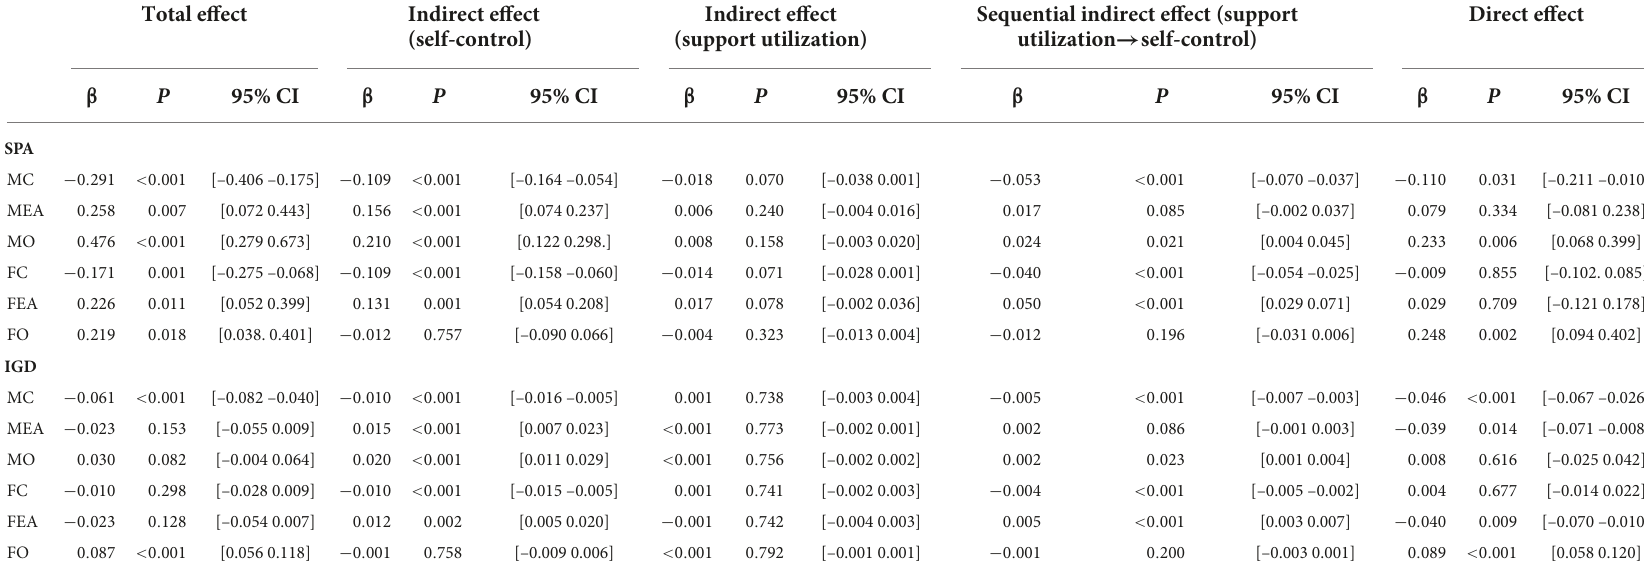
TABLE 7 Effects of support utilization and self-control between parenting styles and SPA and IGD ( n =